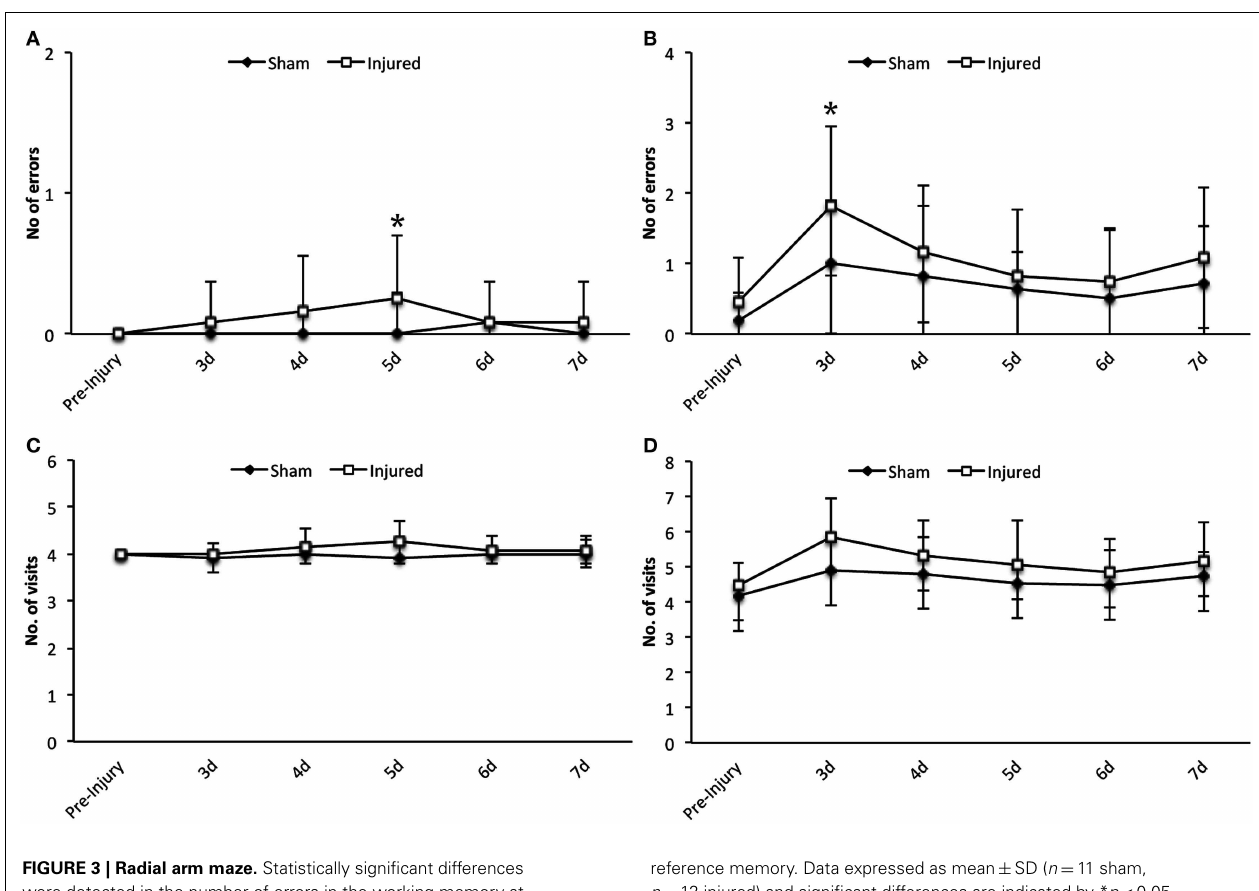
FIGURE 3 | Radial arm maze. Statistically significant differences were detected in the number of errors in the working memory at day 5 (A) and in the reference memory paradigm at day 3 post injury (B) . However as it can be seen in the graphs the numerical difference is not vast and the sham group also show impairment in